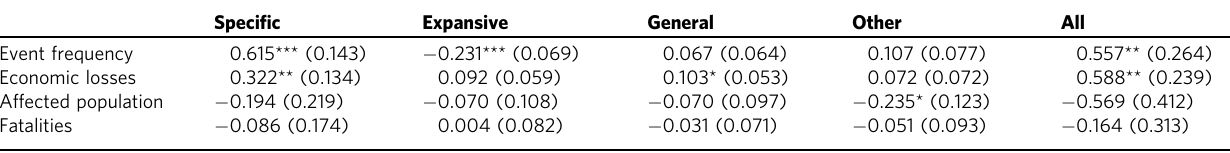
Table 1 Effects of disaster event frequency and severity factors (absolute measures) on types of adaptation actions in